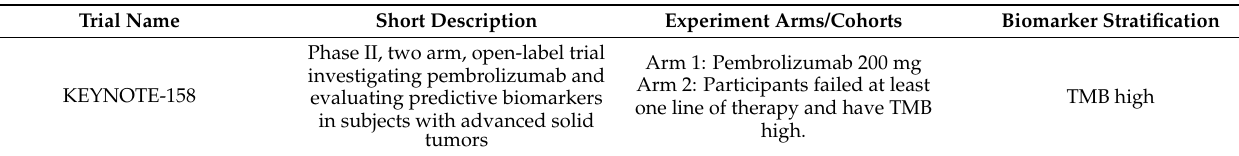
Table 2. Clinical trials utilizing biomarker stratification